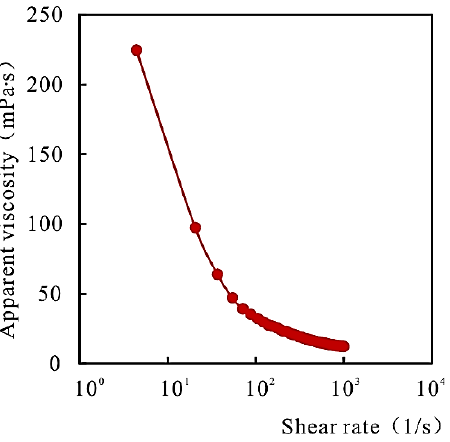
Figure 1. Relationship between polymer shear time and apparent viscosity.